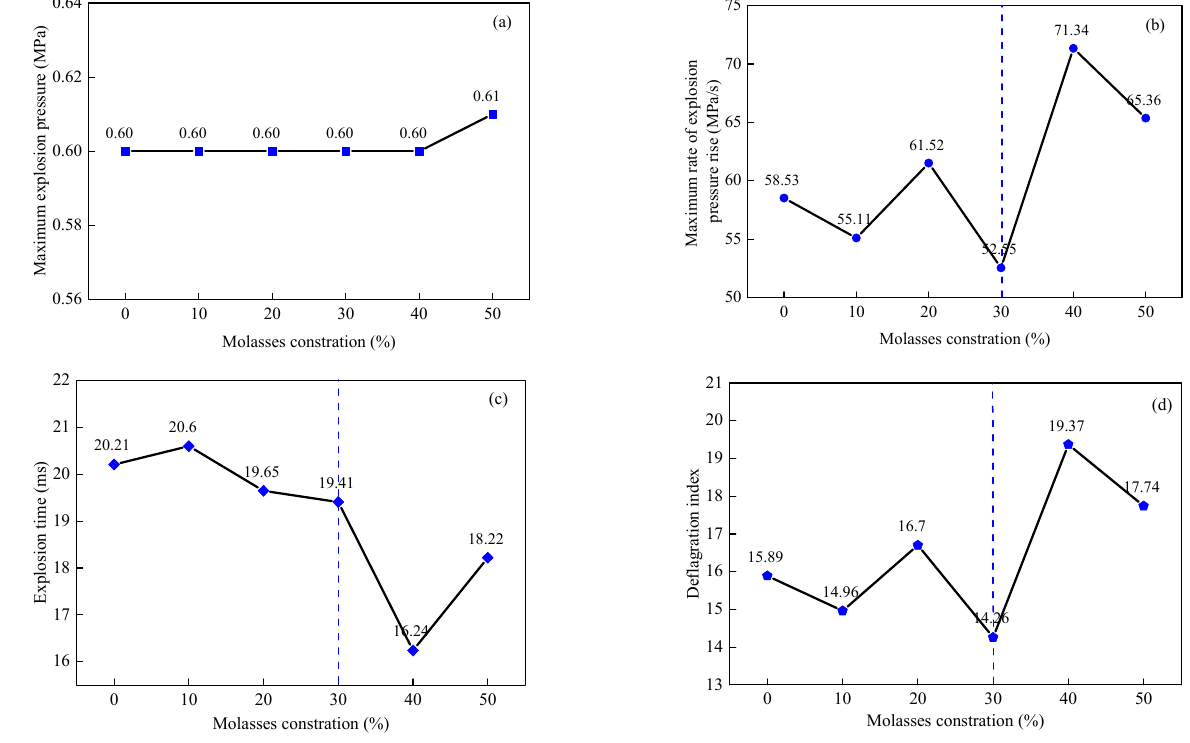
Figure 7. The maximum pressure ( a ), the maximum rate of the explosion pressure rise ( b ), the explosion time ( c ), and the deflagration index ( d ) of the explosion coal dust samples at a 400 g/m 3 explosion concentration.